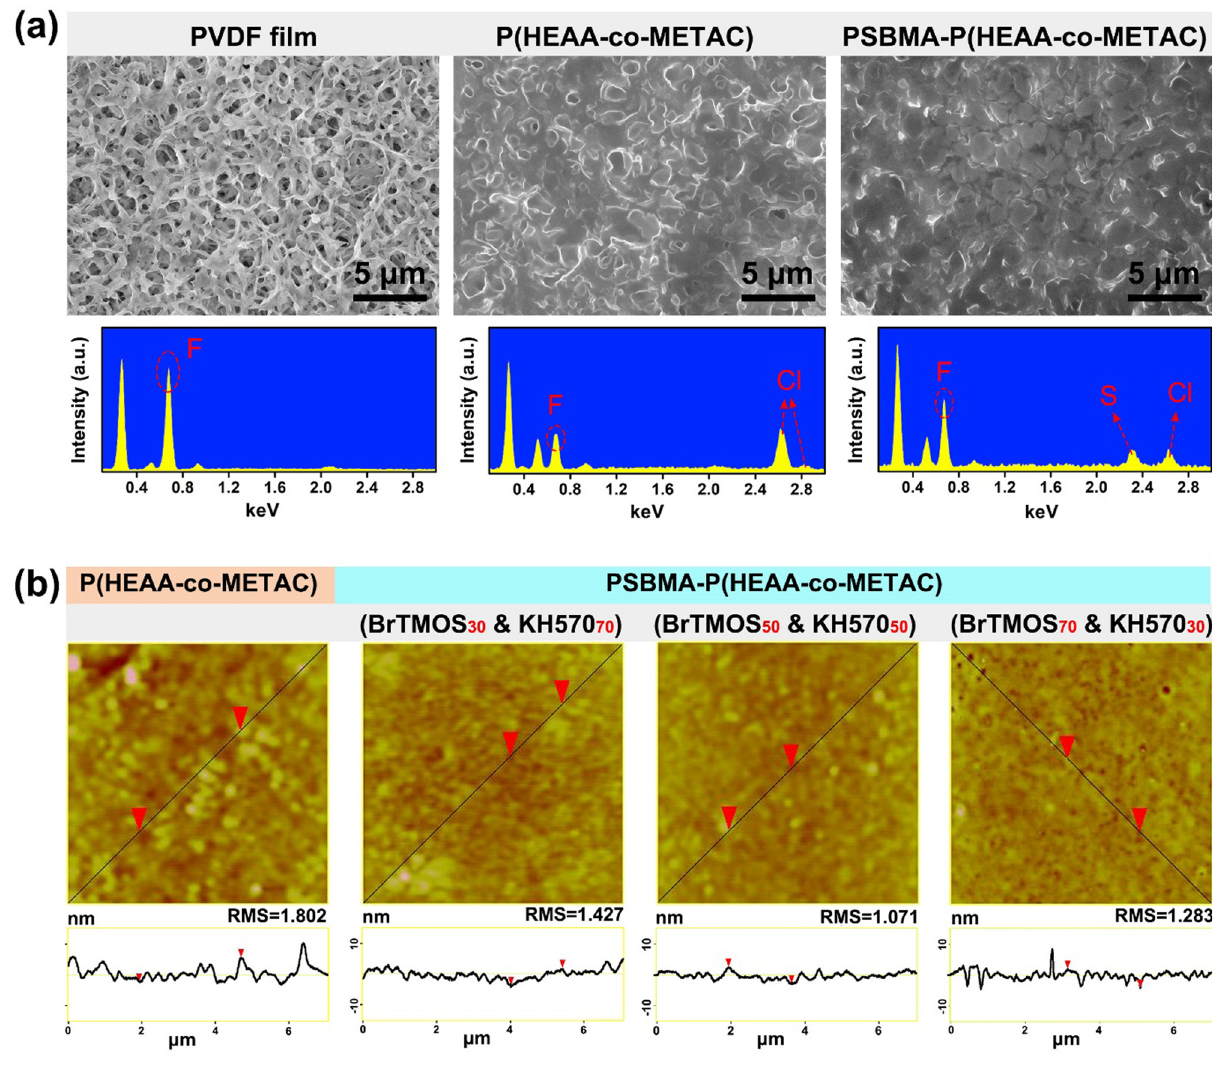
Figure 2: ( a ) SEM images of the pure PVDF fi lm, P ( HEAA - co - METAC ) modi fi ed PVDF fi lm, and PSBMA - P ( HEAA - co - METAC ) modi fi ed PVDF fi lm, and the corresponding EDS mapping images. ( b ) AFM images of P ( HEAA - co - METAC ) and PSBMA - P ( HEAA - co - METAC ) coating, where the content of the SBMA is determined by the organosilanes ratio in the